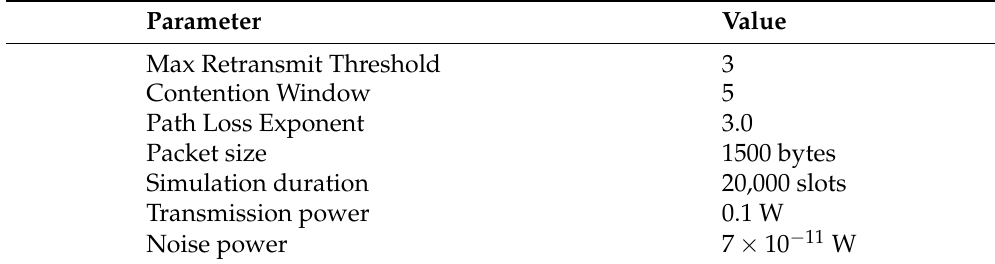
Table 2. Parameters used in the